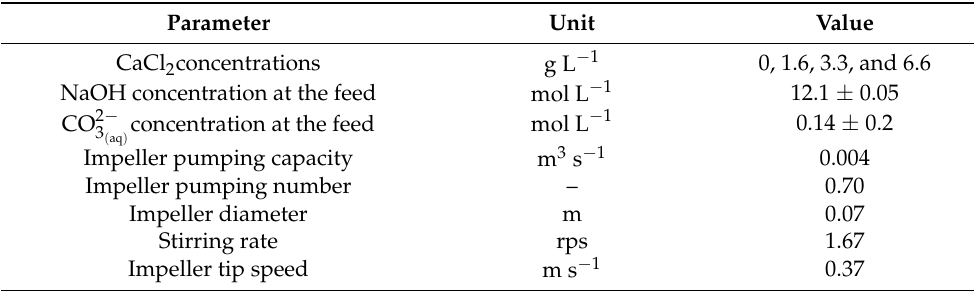
Main operating parameters for the theoretical ion balance modeling and precipitation